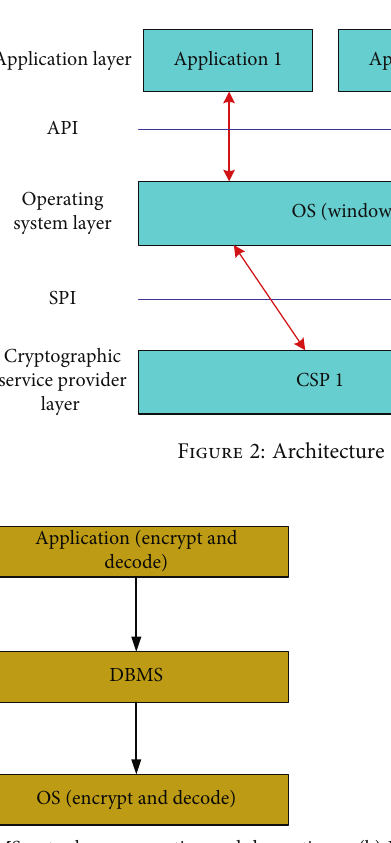
Figure 3: Schematic diagram of encryption and decryption of the inner and outer layers of DBMS.